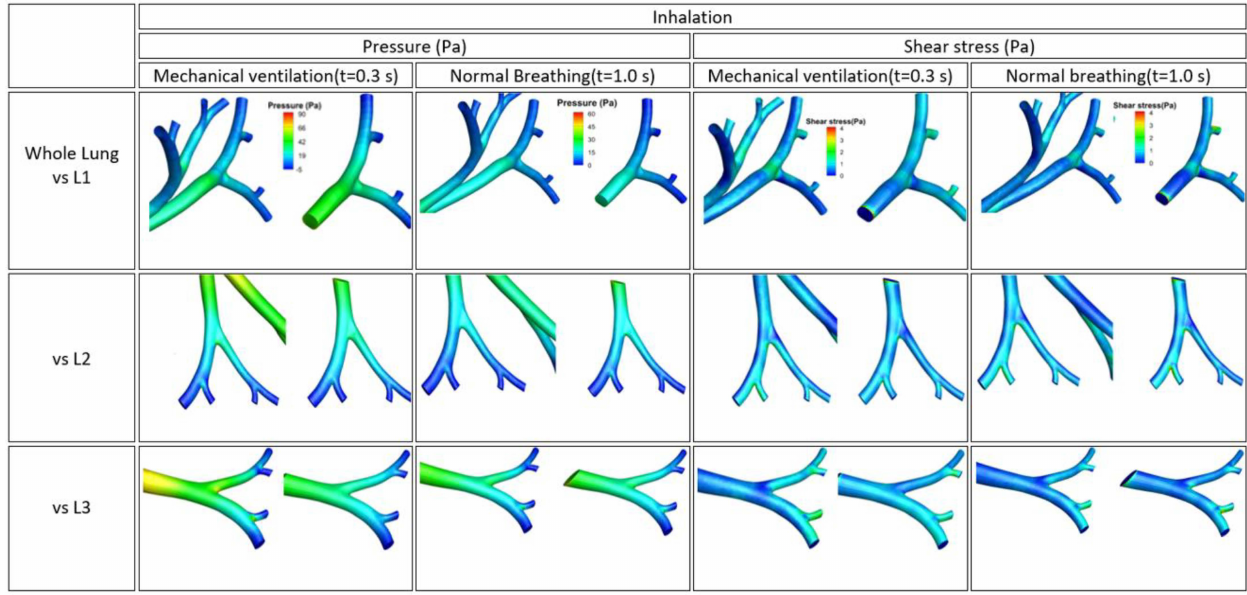
Figure 9. Comparison of pressure and shear stress for left bifurcations of whole lung and isolated local bifurcations (L1, L2, and L3). The plots are for the MV and NB during inhalation at t = 0.3 s, t = 1.0 s, respectively.